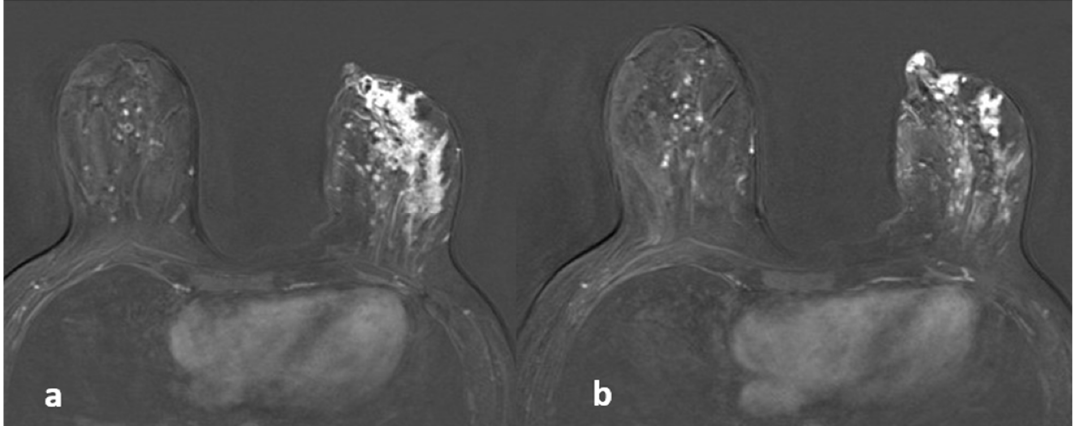
Figure 5. A 42-year-old woman with histopathologically proven invasive ductal carcinoma involving the left breast. ( a , b ) Contrast-enhanced subtracted images show segmental enhancement with clumped internal enhancement pattern extending into the nipple in the left breast. Table 3. Lesion distribution and internal enhancement characteristics of lesions presenting as non- mass enhancement.